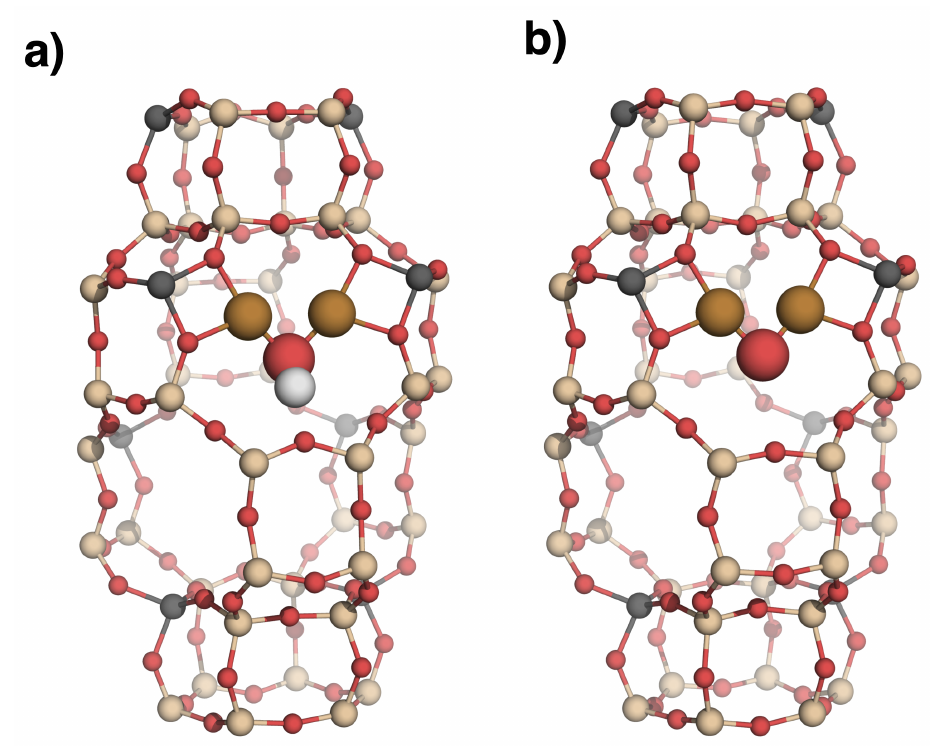
Figure 1. The two investigated active site structures and their positions in the zeolite framework are shown. In ( a ), the Cu 2 OH site in SSZ-13 and in ( b ) the Cu 2 O site in